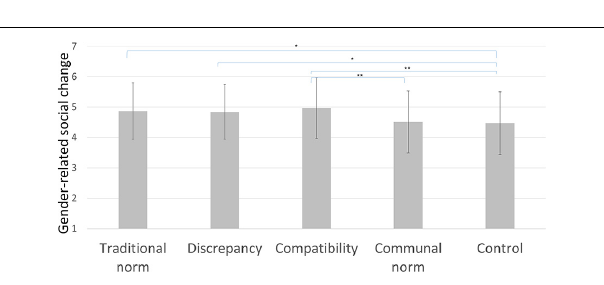
FIGURE 5 | Attitudes toward gender-related social change per condition in Study 2, with SD error bars ( ∗ indicates p < 0.05, ∗∗ indicates p <